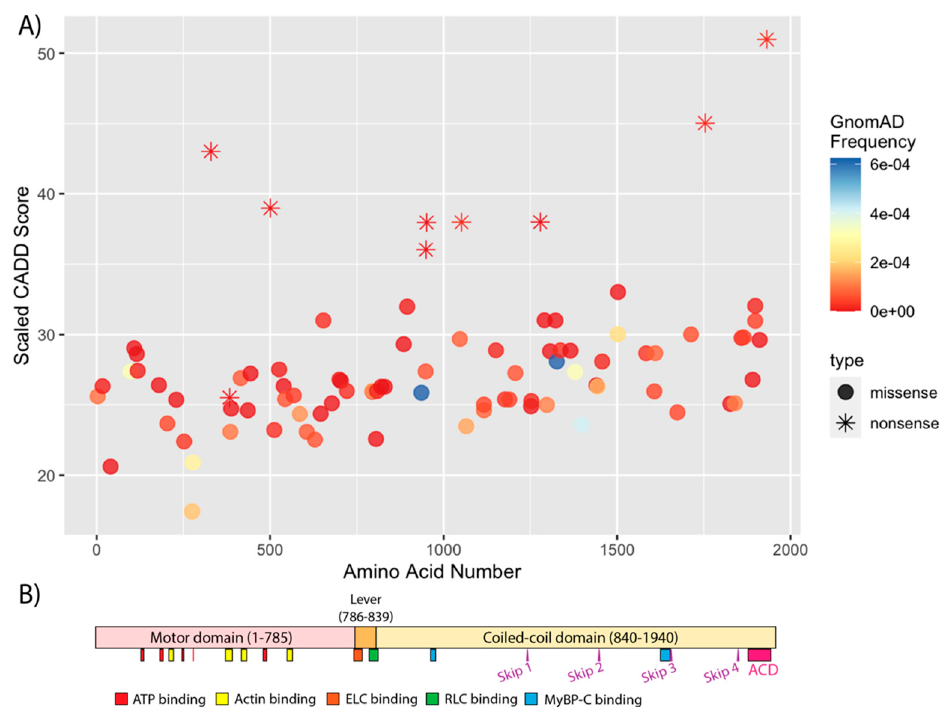
Figure 2. ( A ) Location of rare, predicted damaging MYH6 coding sequence variants by residue. Variants were considered rare if allele frequency was <1 × 10 − 3 in both the Genome Aggregation Database (gnomAD) Genomes dataset v3.1.2 and the Allele Frequency Aggregator (ALFA) dataset (release version 20201027095038). Single nucleotide variants were considered predicted damaging if the scaled Combined Annotation Dependent Depletion (CADD) score was >22.0 (GRCh37, v1.6) [60], or if the variant was predicted “damaging” or “probably damaging” by SIFT [61] and PolyPhen2 [62]. Deletions are not shown as CADD scores cannot be calculated. ( B ) Schematic of α —MHC domains. ELC, essential light chain; RLC, regulatory light chain; MyBP—C, myosin binding protein C; ACD, assembly competent